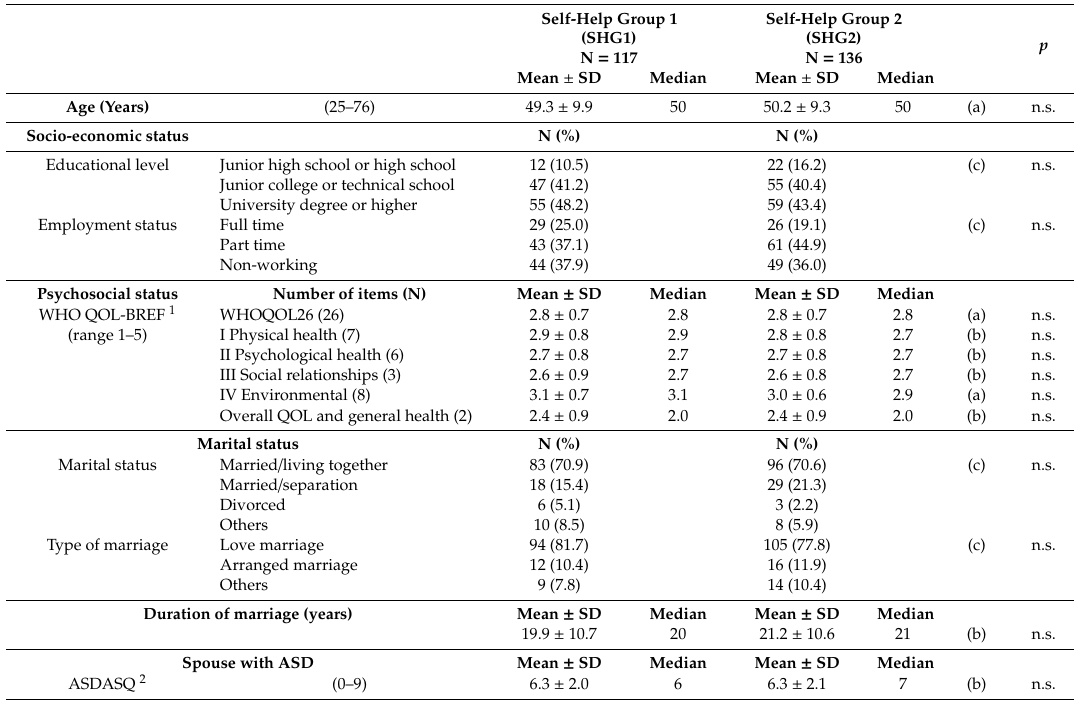
Table 1. Socio-demographic characteristics of participating spouses of people diagnosed with autism spectrum disorder (ASD) (N =